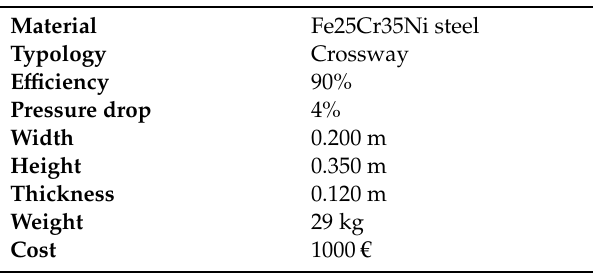
Table 8. Recuperator